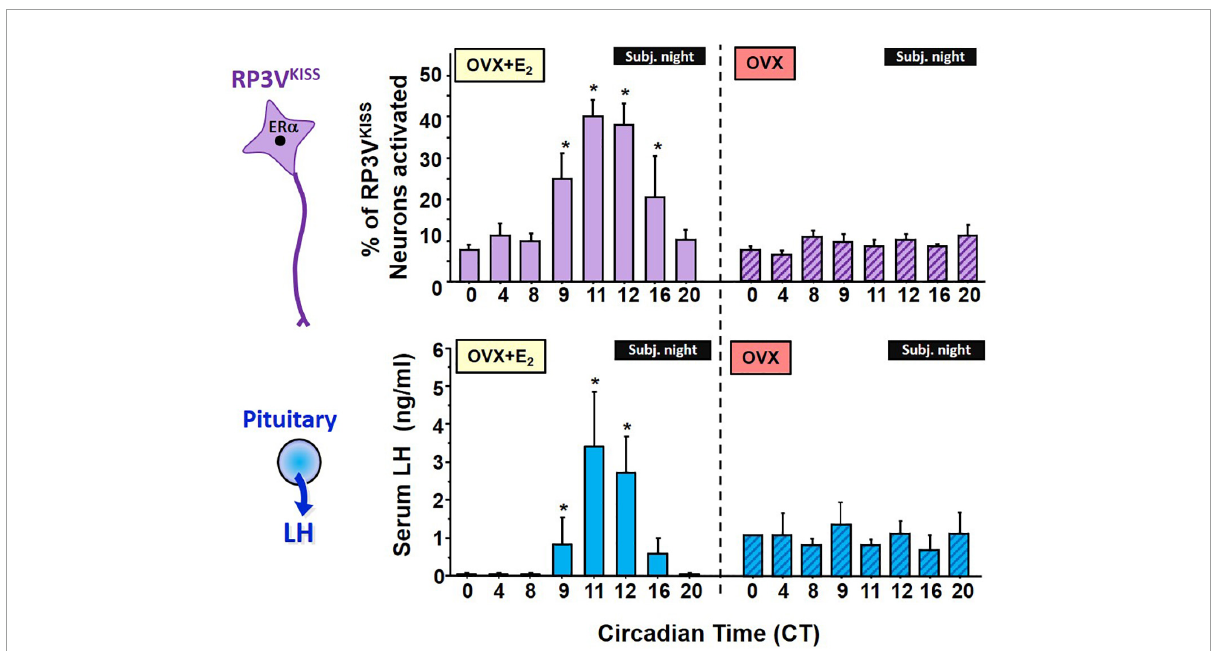
FIGURE2 Circadian changes in RP3V KISS neuron activation, measured by cfos mRNA induction, and serum LH levels in OVX + E 2 female mice housed in constant darkness (DD). The onset and peak of RP3V KISS neuron activation mirrors the rise and peak of LH surges, which occur right before the onset of subjective night (defined as the daily onset of locomotor activity, a robust circadian behavioral measure). For comparison, a separate cohort of OVX females not receiving E 2 were similarly studied but showed no circadian increases in either RP3V KISS neuron activation or serum LH levels. Note that baseline LH levels in the OVX females are higher than in OVX + E 2 due to lack of gonadal steroid negative feedback in the former group. *, Significantly different than baseline levels at CT 0. Adapted from Robertson et al.